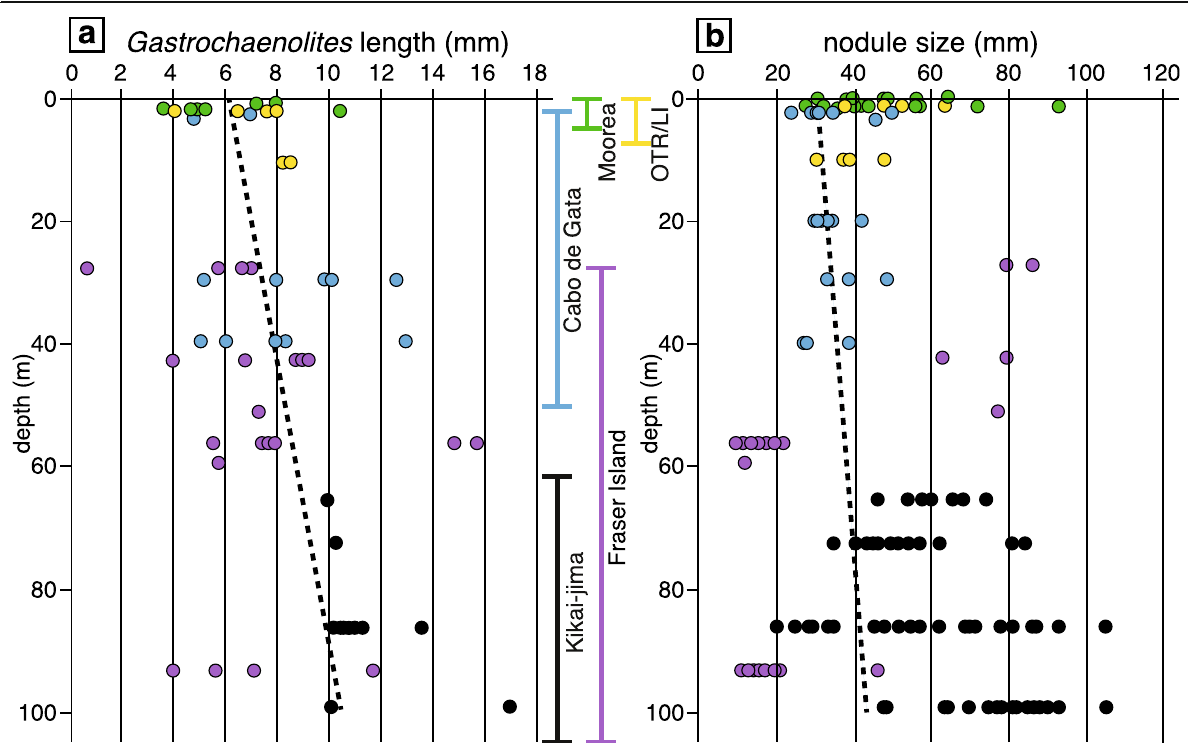
Fig. 8 Plots of ( a ) length of Gastrochaenolites ichnospecimens and water depth ( R = 0.44, p = 0.001, total n = 57; Fraser Island n = 21; Kikai-jima, n = 11; Cabo de Gata, n = 12; Moorea, no = 7; One Tree Reef/Lizard Island, n = 6), ( b ) Macroid and rhodolith sizes and water depth ( R = 0.16, p = 0.0145, n = 234) from the six study cases. The sampled bathymetric ranges of the studied beds are also reported for each studied locality (vertical bars). OTR/LI, One Tree Reef/Lizard Island